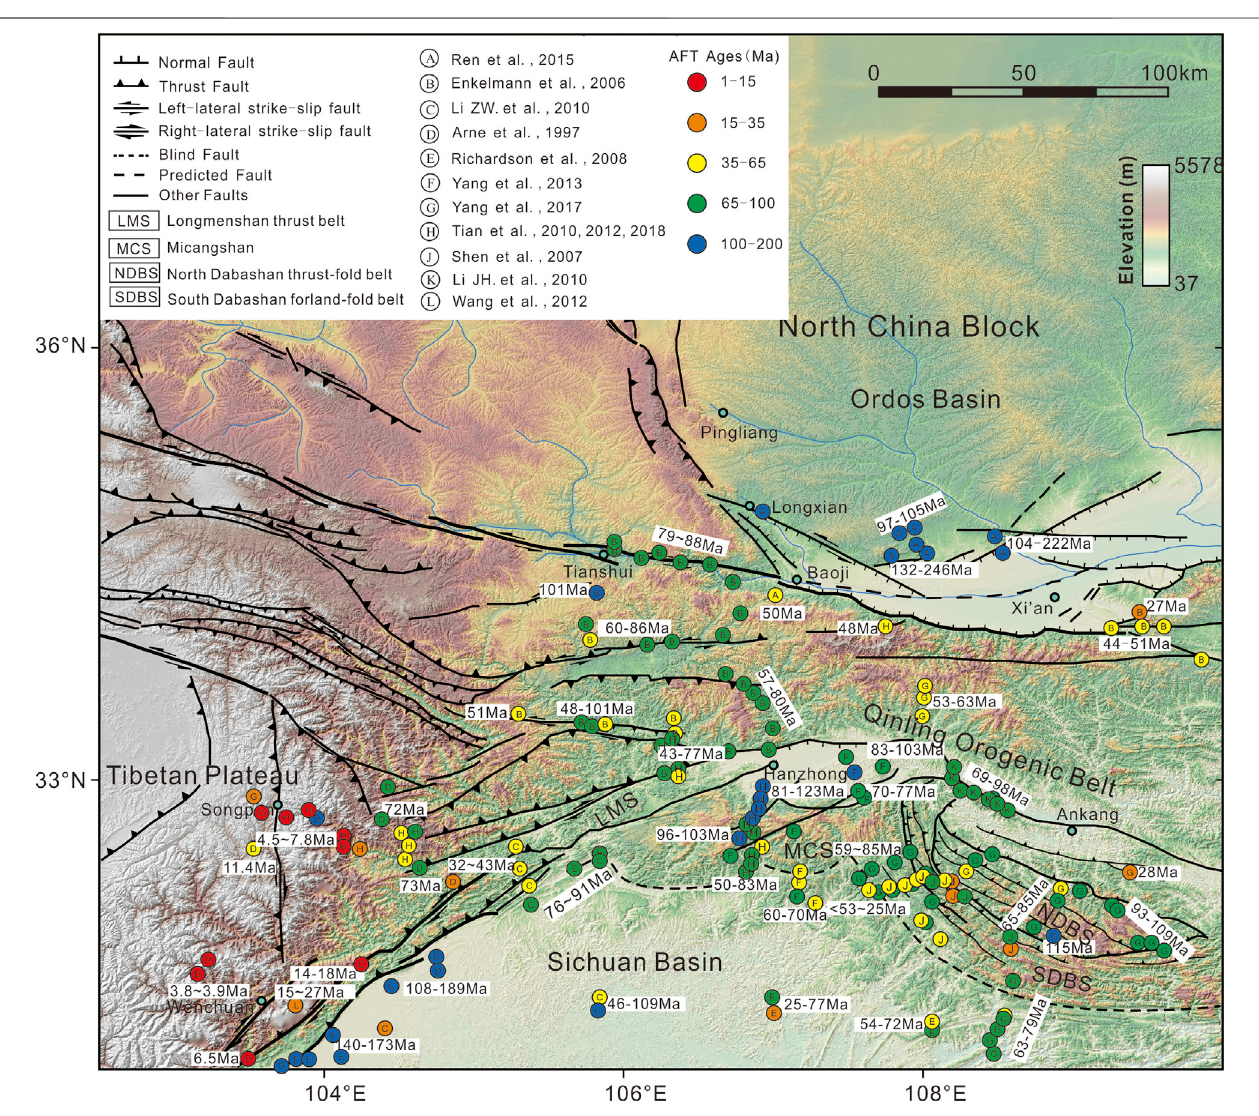
FIGURE1| Publishedapatite fi ssiontrack(AFT)ages(inMa)plottedongeologic-tectonicmapsoftheMicangshan,Dabashanandadjacentregions;differentages are noted in different colours.